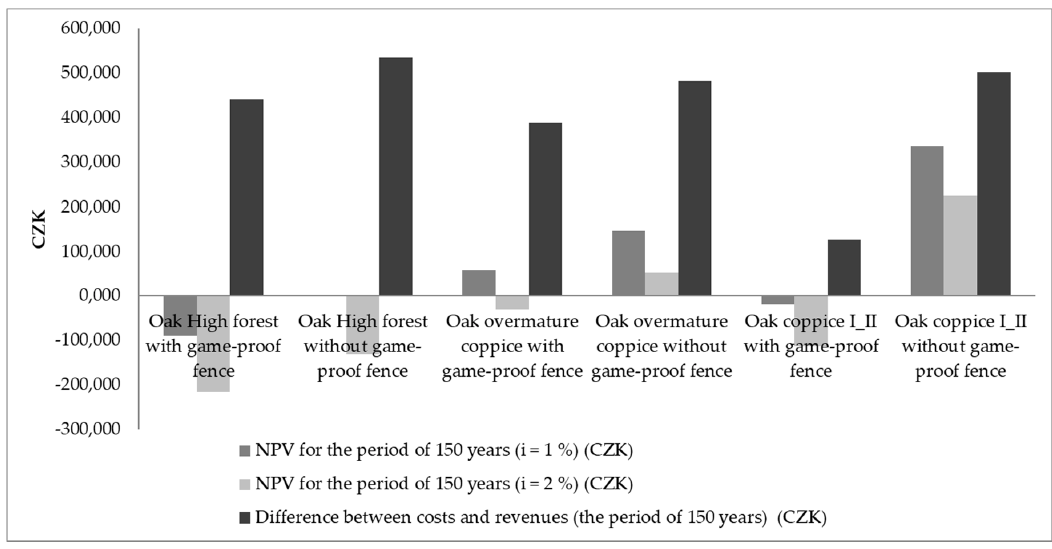
Figure 3. Economic comparison of oak stand management options in LP K ř ivoklátsko.